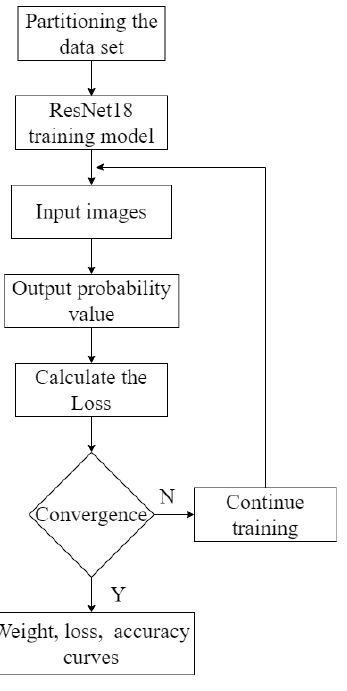
Figure 16. ResNet18 training process.